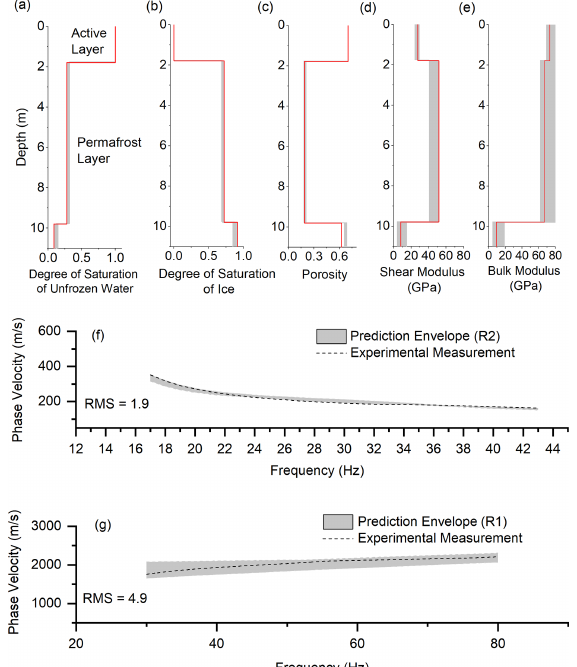
Figure B4. Surface wave inversion results for section 5 (from 480 to 600m). (a) Degree of saturation of unfrozen water, (b) degree of saturation of ice, (c) porosity distribution, (d) shear modulus of solid skeletal frame, (e) bulk modulus of solid skeletal frame, (f) experimental and numerical dispersion curves for the R2 wave, and (g) experimental and numerical dispersion curves for the R1 wave.